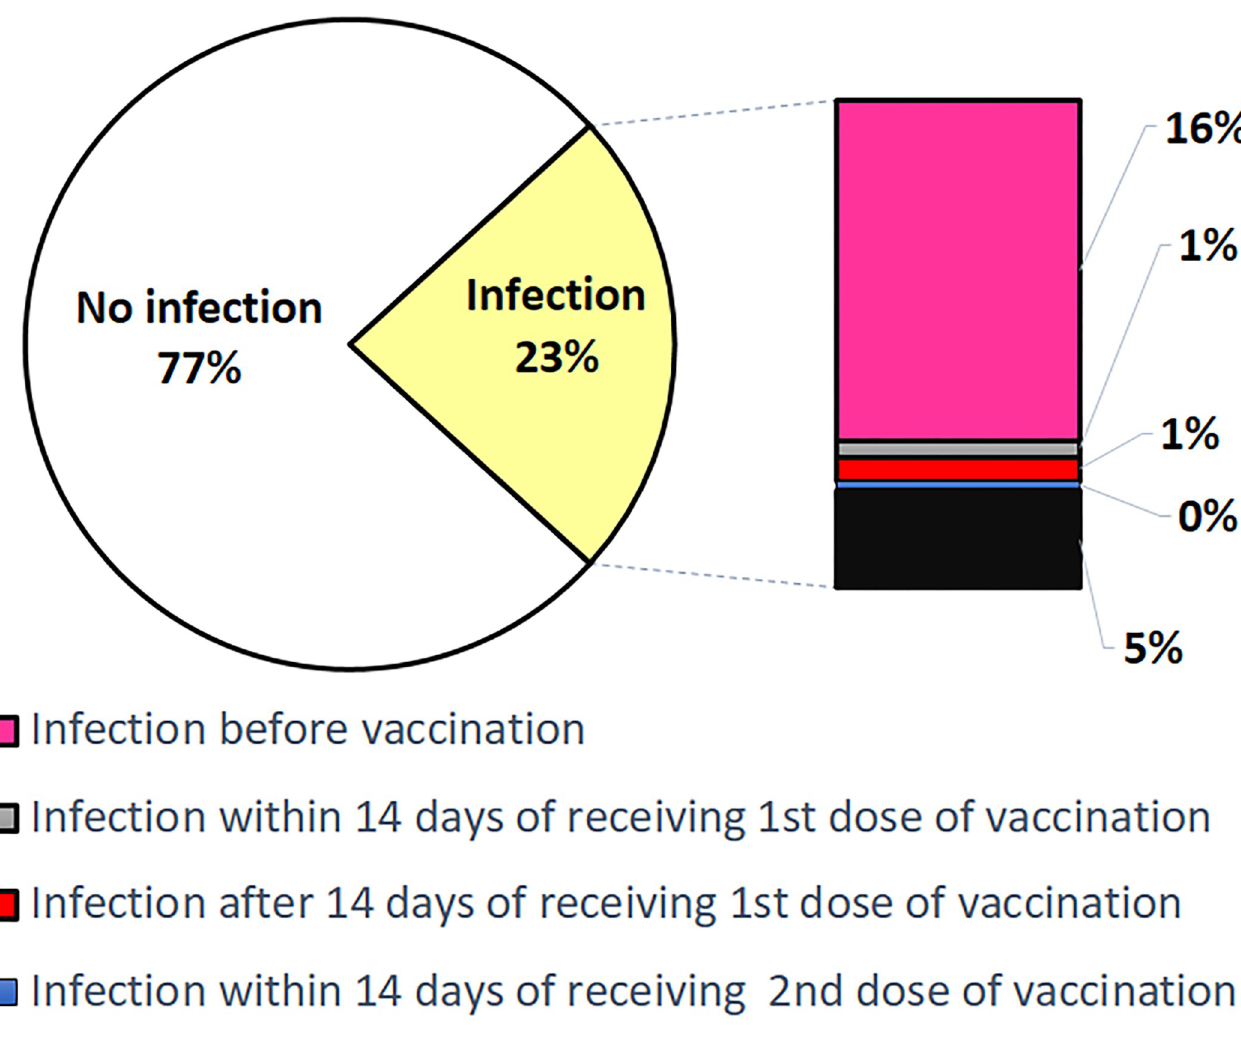
Fig 3. Infection distribution based on